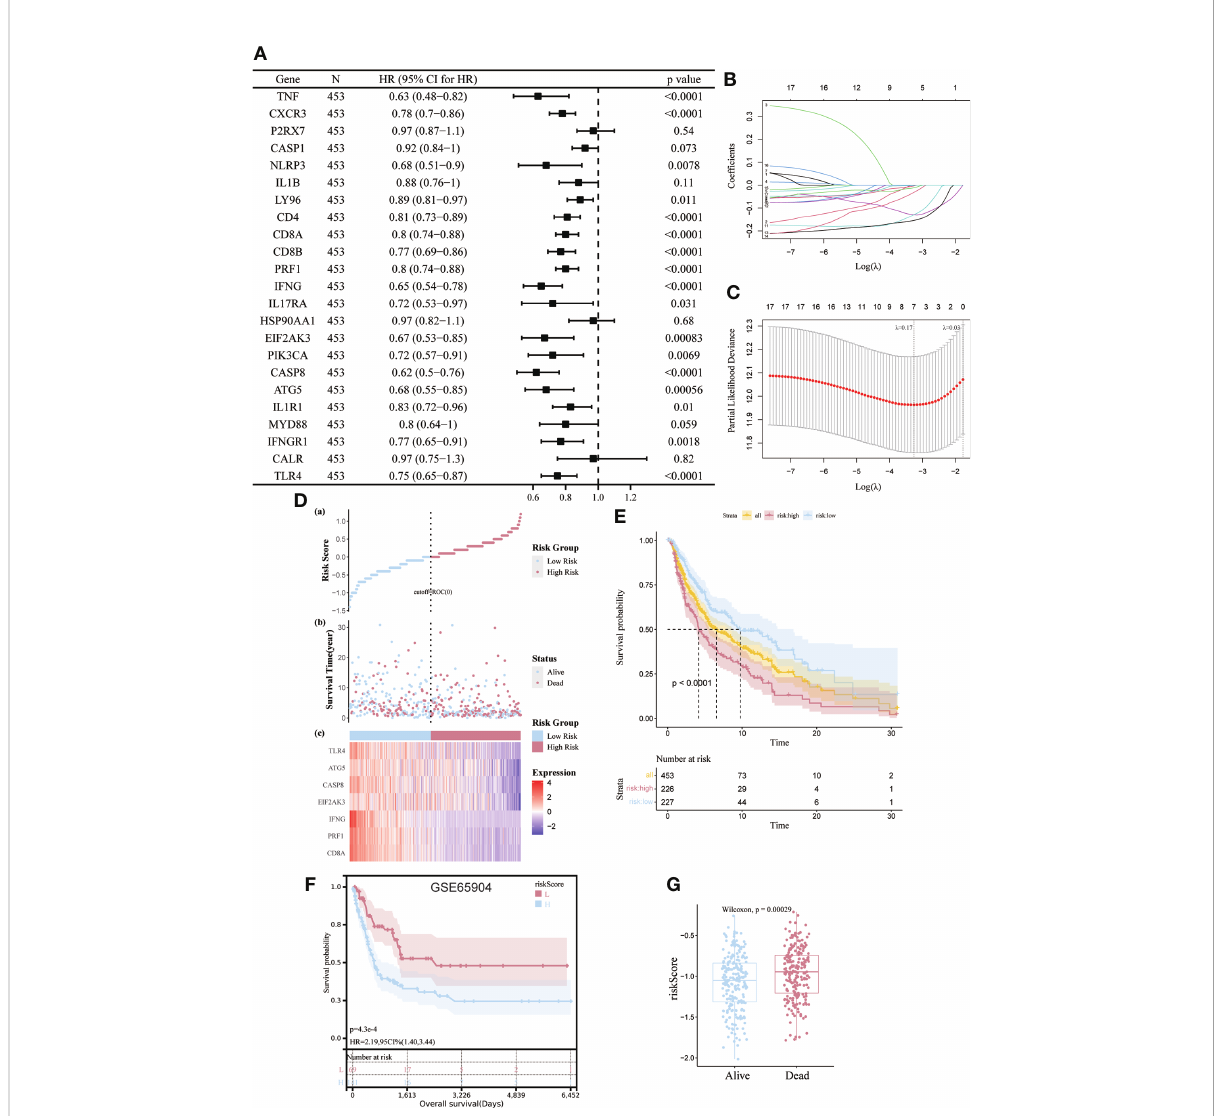
FIGURE 6 Construction and validation of risk models. (A) Univariate Cox analysis to assess the prognostic value of ICD genes in terms of OS; (B, C) Lasso Cox analysis to identify the seven genes most associated with OS in the TCGA dataset; (D) Heat map of the risk score distribution, survival status and prognostic 7-gene signature for each patient in the TCGA database; (E, F) Kaplan- Meier analysis demonstrating the prognostic signi fi cance of the risk model in the TCGA and GSE65904 cohort; (G) Box plots representing the relationship between patient survival status and risk